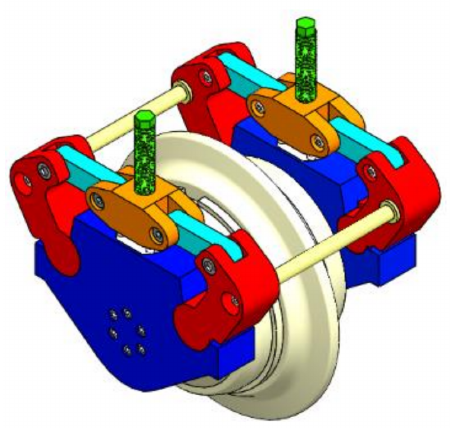
Figure 7. Schematic diagram of the parts grasped by the TBM cutter-change